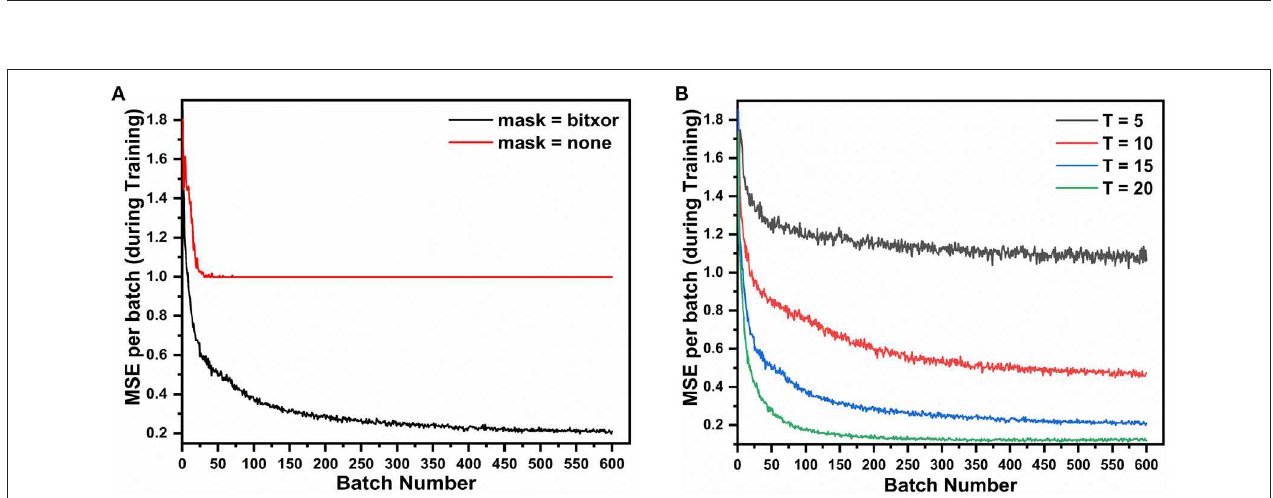
FIGURE 3 | The AE-SNN (784-196-784) is trained over MNIST (60,000 training samples, batch size = 100) for different leak coefficients ( α ). (A) spike-based MSE (Mean Square Error) Reconstruction Loss per batch during training. (B) Average MSE over entire dataset after training.